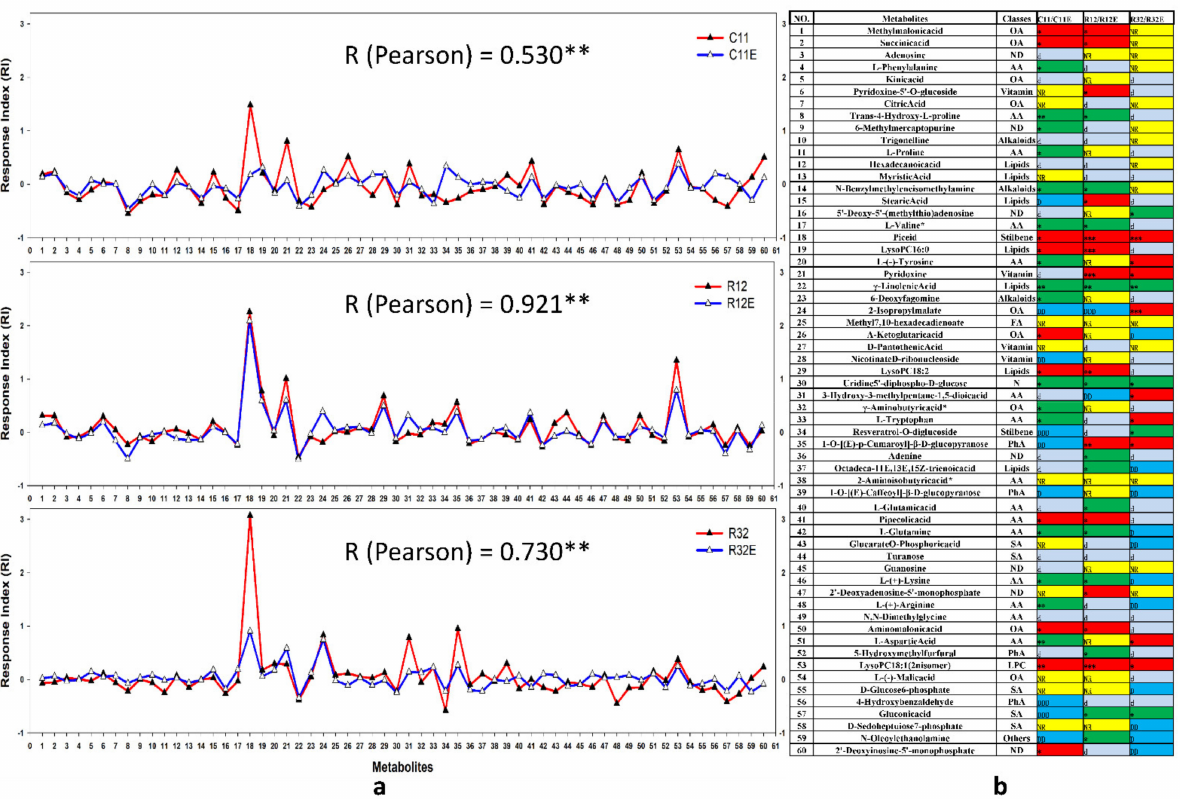
Figure 4. Coordinative responses of metabolites in grape cells exposed to endophytic fungi (EF) and corresponding fungal extracts (CFE). C11, R12, R32, C11E, R12E, and R32E briefly represent the sample groups treated with the corresponding endophytic fungal strains or their derived fungal extracts. The coordinative responses of the metabolites were analyzed according to the values of the response indexes (RIs), and the results show the coordinative responses of the top 60 metabolites with the most relevant contents (top 60 metabolites) that occupied more than 90% of the detected total metabolites in this experiment. ( a ) Correlations among metabolites in grape cells in each paired treatment, where ** indicates critically significant correlations at 0.01. ( b ) Response types of the top 60 metabolites in grape cells in each paired treatment: coordinately responded metabolites (CRMs, marked in red [upregulated, RI values of both treatments in the paired treatments (RIPT) more than or equal to 0.1] and green [downregulated, RIPT ≤ − 0.1]); differentially responded metabolites (DRMs, blue); almost non-responding metabolites (NR, in yellow); and other responding metabolites (d, in gray) in grape cells of each paired treatments. The degrees of coordination of the CRMs are represented by 1–3 stars: *, absolute RIPT greater than or equal to 0.1 and less than 0.3; ** RIPT